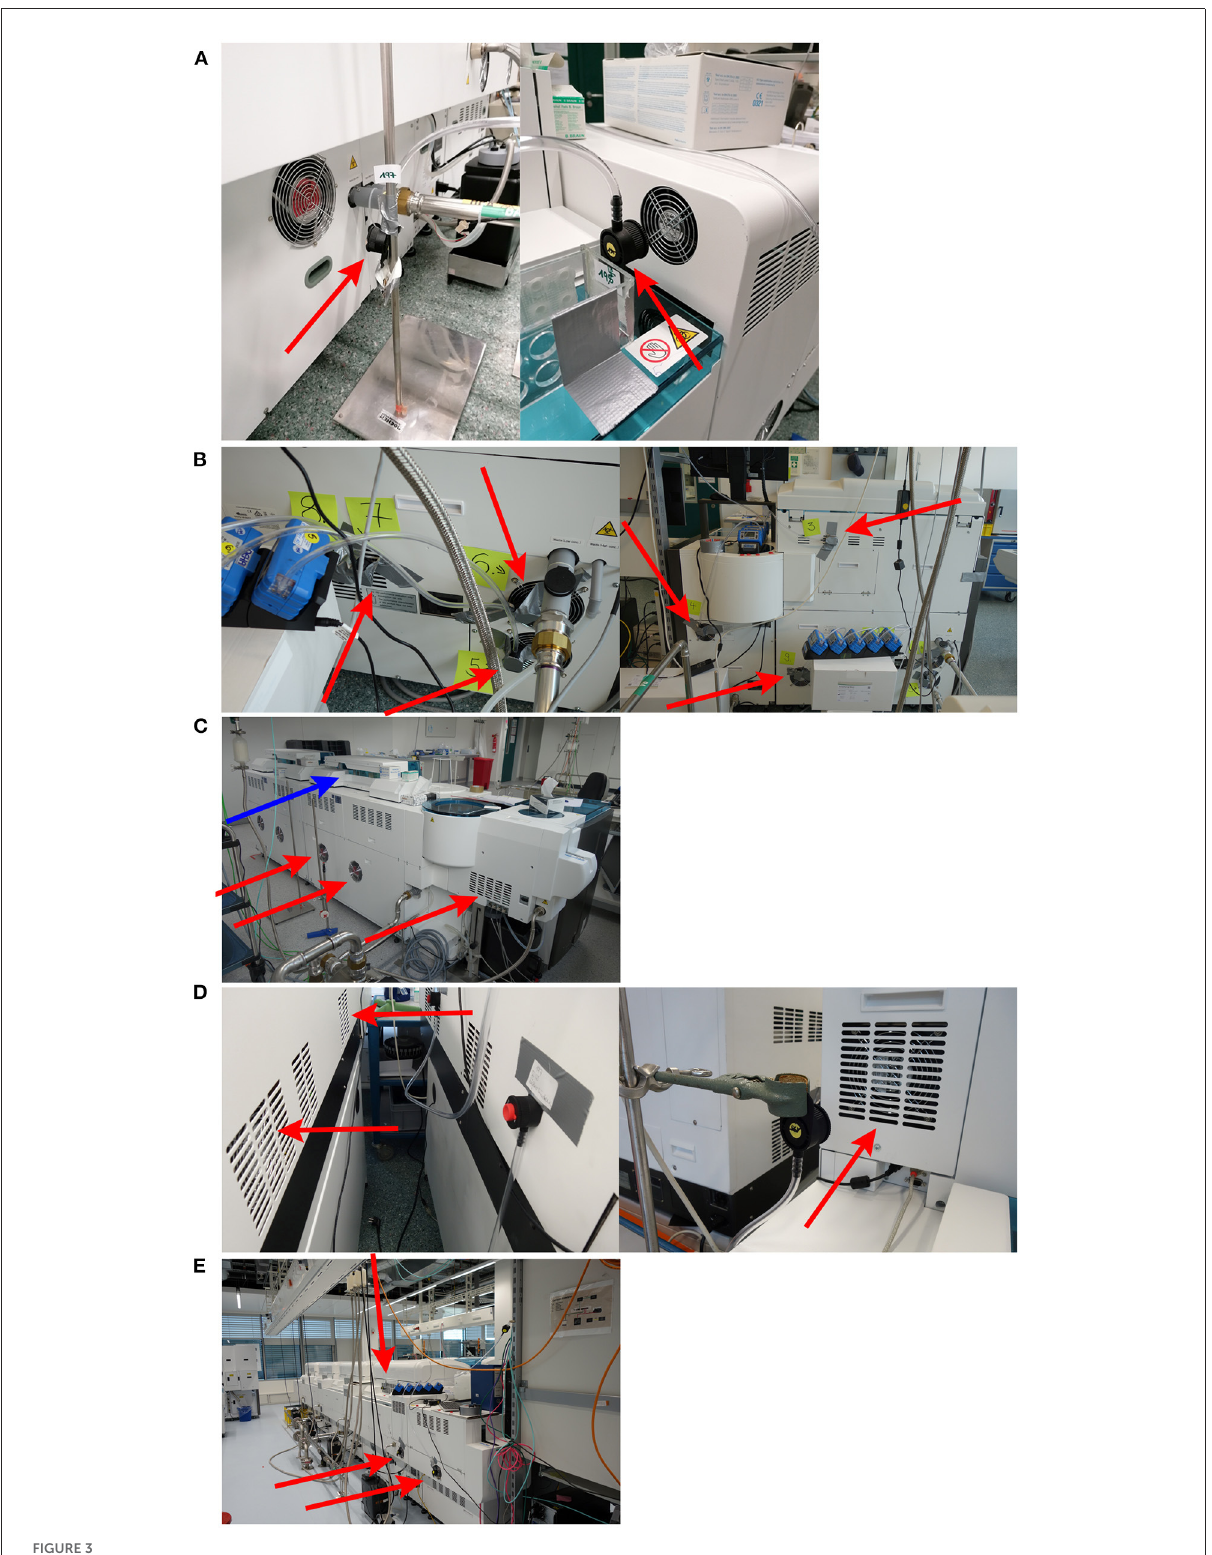
FIGURE3 Selection of air sampling positions included in the cobas e analyzer panel sub-study*. (A) cobas e 801 analytical unit (cobas 8000 configuration). (B) cobas e 402 analytical unit (C) cobas e 601 module. (D) cobas e 411 analyzer. (E) cobas e 801 analytical unit in combination with cobas pro integrated solution. *Positions of air sampling around fan outlets are indicated by red arrows and the sample pipette location is indicated by a blue